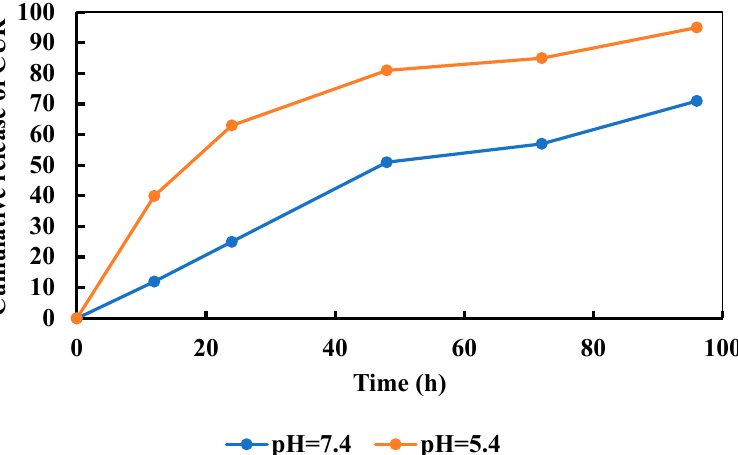
Figure 9. In vitro release profile of CUR from PVA/GO-Ag-CUR nanofiber in pH 5.4 and pH 7.4 at 37 °C at predetermined time intervals using the dialysis method.